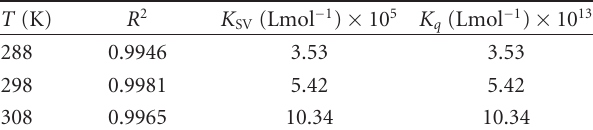
Table 1: The quenching constants of the Pt(II) complex by CT- DNA at di ff erent temperatures.